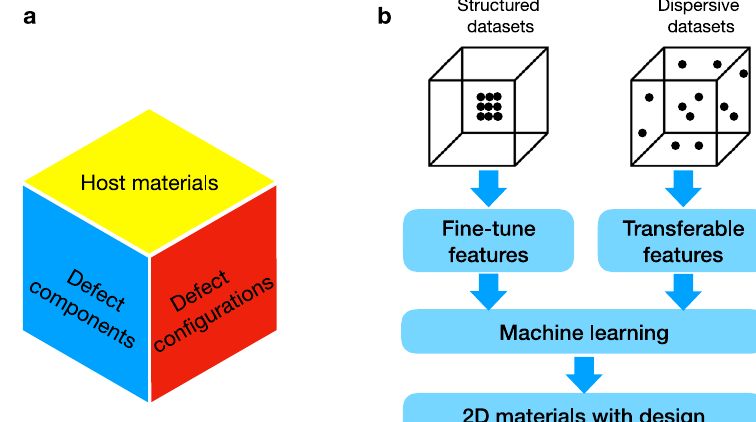
Fig. 1 Machine learning-friendly 2D material defect (2DMD) datasets. a The space of defects in 2D materials and b the structure of the datasets for machine learning of defect